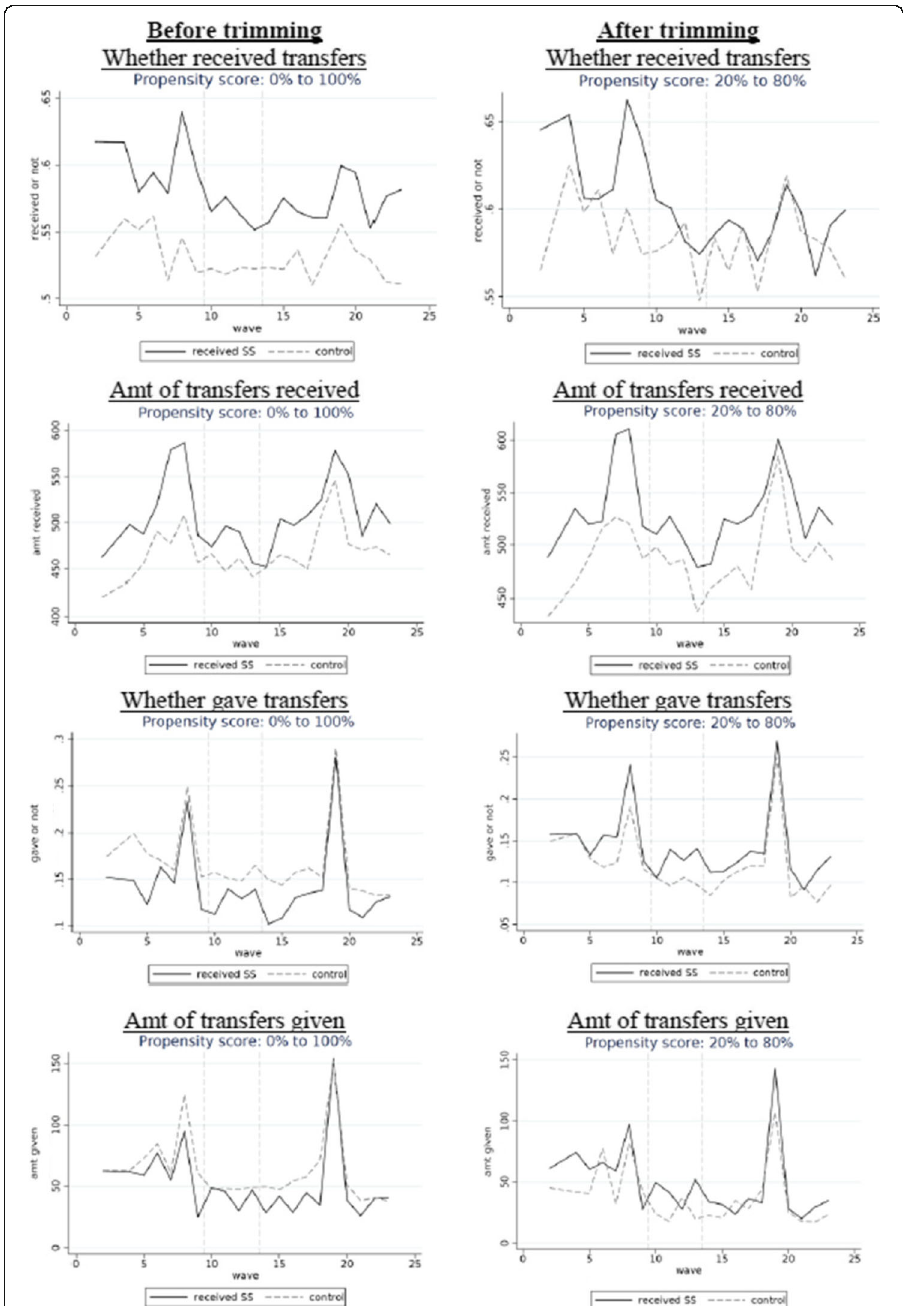
Fig. 3 Trends of key private transfer-related variables (The periods to the left of the first and second dotted vertical lines refer to the pre-announcement and pre-disbursement periods